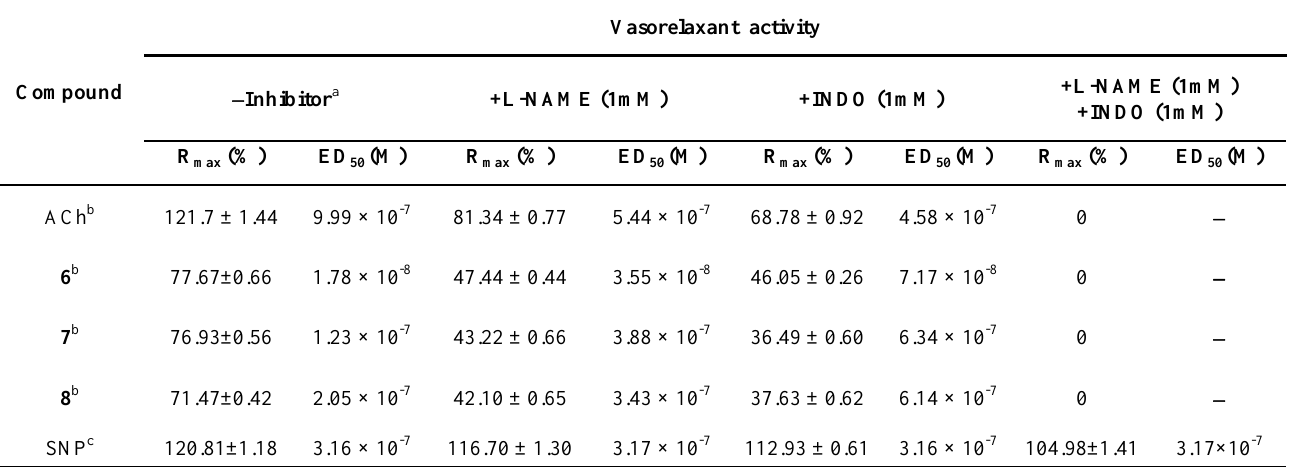
Table 3. Effect of inhibitors on vascular effect of nicotinic acid analogs 6 - 8